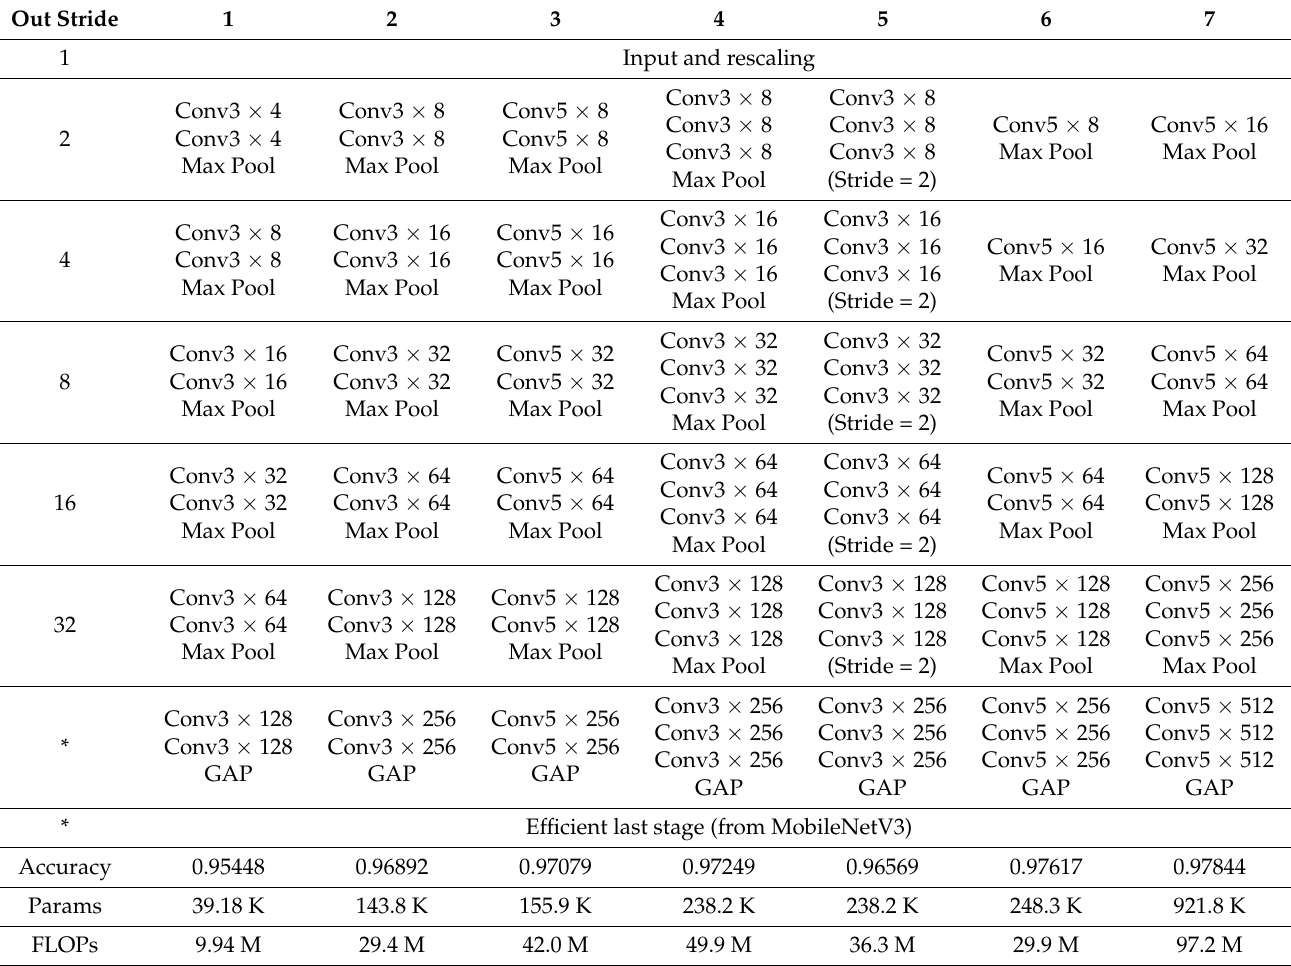
Table 2. List of Naive CNN